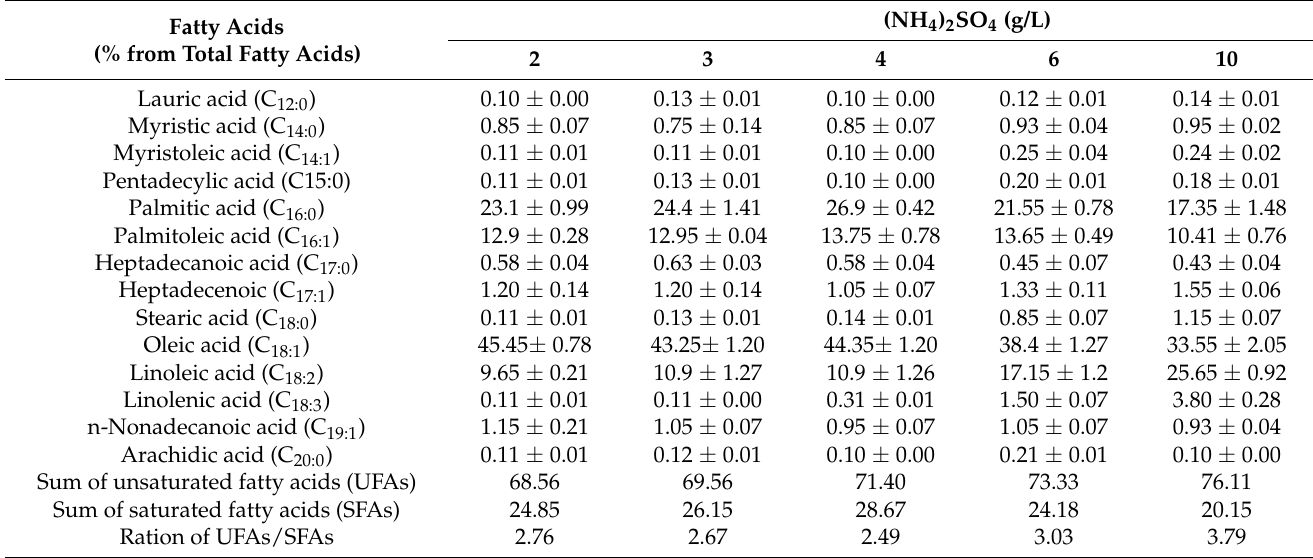
Table 4. Fatty acid composition of Y. lipolytica VKM Y-2373 at different nitrogen concentrations.